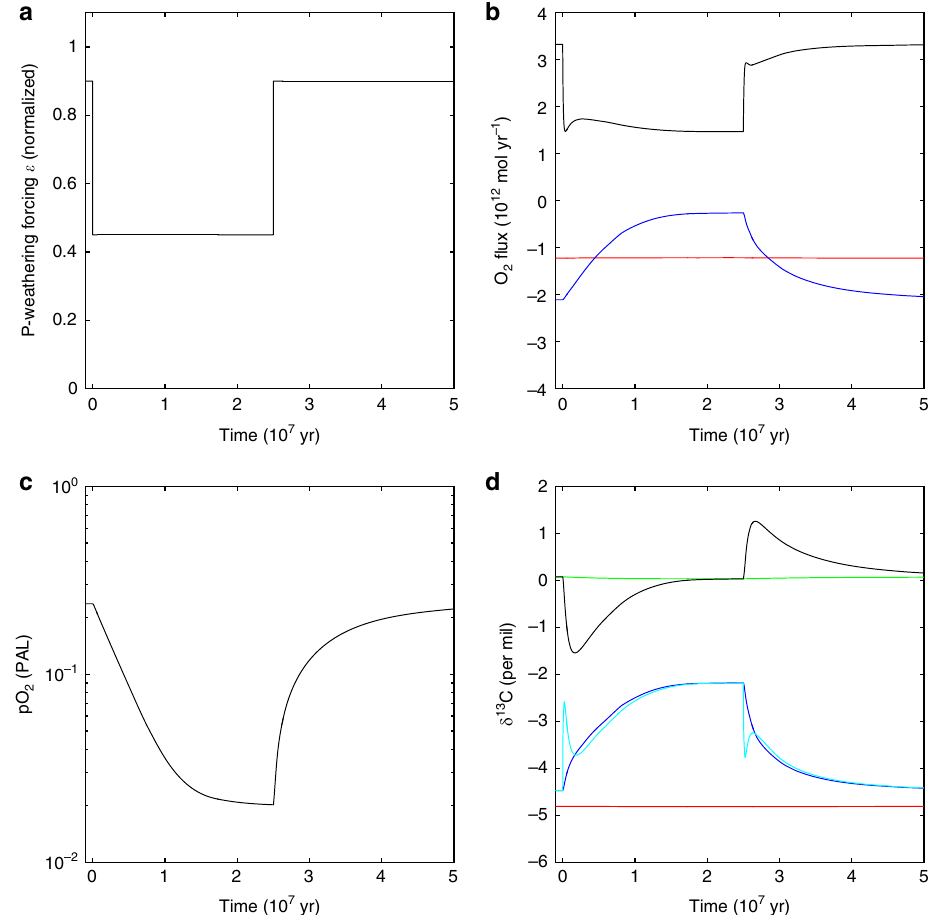
Figure 4 | Transient response to changes in organic carbon burial flux. Results from the Precambrian COPSE model with perturbation applied to the model steady-state at 1Ga (see ‘Methods’ section). ( a ) Phosphorus weathering perturbation via parameter e . ( b ) Atmosphere/ocean oxygen fluxes: source from marine organic carbon burial (black), sinks from atmospheric reactions with reduced volcanic/metamorphic gases (red), and oxidative weathering (blue). ( c ) Atmospheric oxygen pO 2 showing decrease and approach to new steady-state at 25My, where oxidative weathering and volcanic sinks again balance production by carbon burial, followed by return to initial level. ( d ) Carbon isotope responses of marine carbonate burial d 13 C carb (black), input (blue) and output (cyan) to ocean/atmospheric system, with mean of sedimentary carbonate carbon (green) and degassing (red). Oxidative weathering initially exceeds organic carbon burial, resulting in a negative d 13 C transient. After B 10Myr, atmospheric oxygen and oxidative weathering decrease, leaving d 13 C unchanged. Similar behaviour occurs when organic carbon burial is increased again after 25Myr.